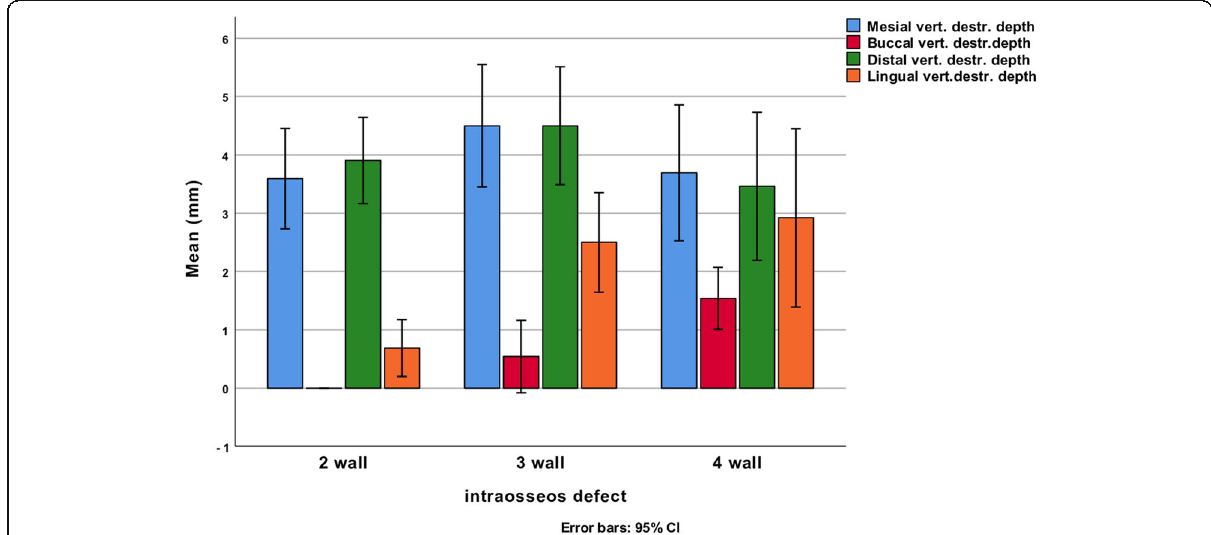
Fig. 2 Defect depths assessed clinically during surgery from the bone crest to the defect